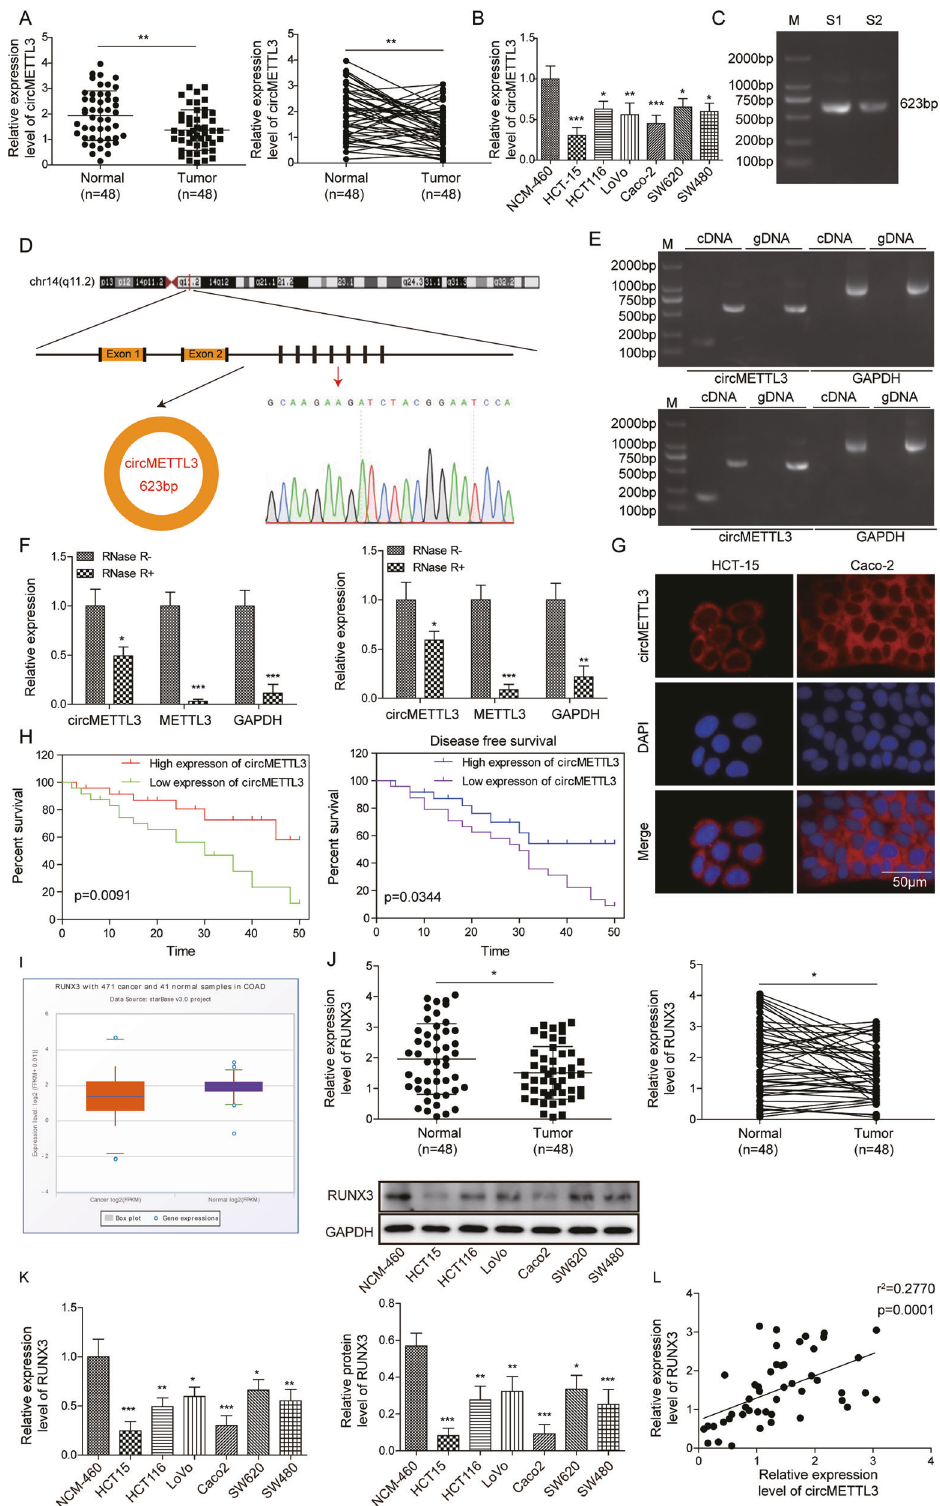
Fig. 1 RUNX3 and circMETTL3 were reduced in CRC tissues and cells. A Relative circMETTL3 levels in CRC tissues. Left: mean level; Right: paired comparison. B Relative circMETTL3 levels in CRC cell lines. C Detection of circMETTL3 in CRC cells. D Sanger sequencing of circMETTL3. E RT-PCR to characterize circMETTL3 circular features. F Characterize the stability of circMETTL3 by RNase digestion. G FISH to analyze the localization of circMETTL3. H Correlation between circMETTL3 level and overall survival rate and disease free survival rate of CRC patients. I Relative RUNX3 mRNA levels in CRC tissues from TCGA database. J Relative RUNX3 mRNA levels in CRC tissues. Left: mean level; Right: paired comparison. K Relative RUNX3 mRNA and protein levels in CRC cell lines. L Positive correlation between RUNX3 level and circMETTL3 level in CRC